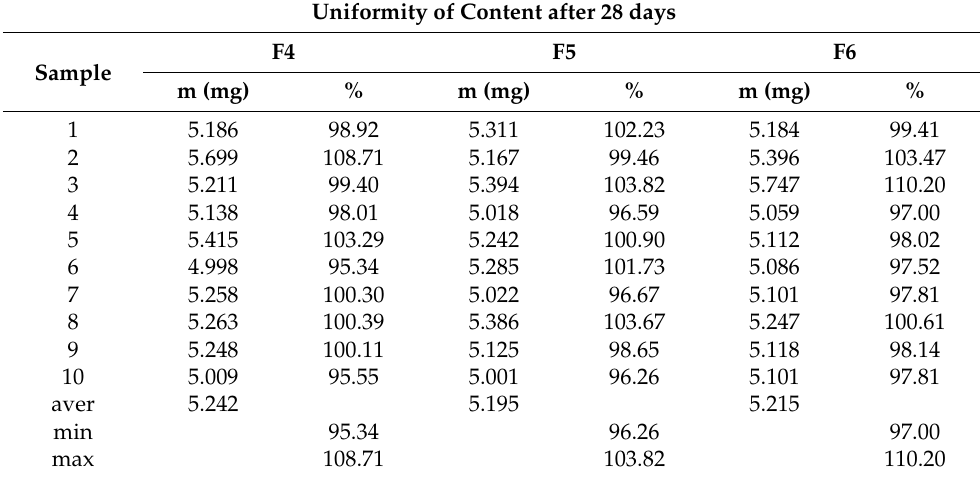
Table 6. Uniformity of pantoprazole content (mg/capsule) in three formulations (F4, F5, F6) after 28 days.